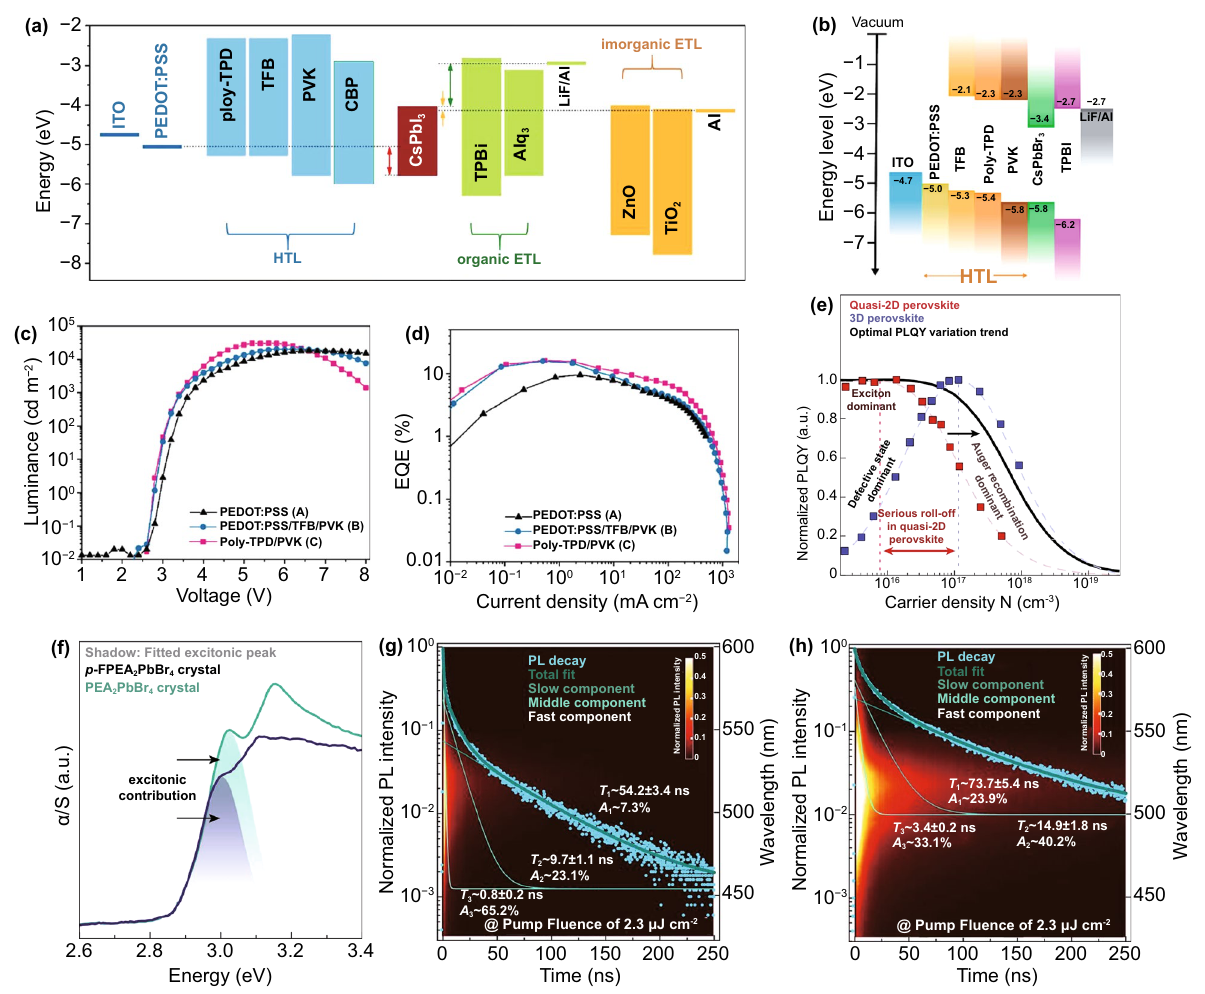
Fig. 7 a Schematic diagram showing energy levels of typical electrodes, charge transport materials and CsPbI 3 . Copyright 2020 American Chemical Society [100]. b Energy level diagrams of quasi-2D PeLEDs and different HTLs. c L-V and d EQE-J of PEDOT: PSS, PEDOT: PSS/ TFB/PVK, poly-TPD/PVK. Copyright 2020 American Chemical Society [102]. e Experimental PLQYs of quasi-2D perovskite and 3D perovs- kite films as a function of carrier density. f Absorption spectra of PEA2PbBr4 and p-FPEA 2 PbBr 4 single crystals. Time- and wavelength-depend- ent photoluminescence mapping under a pump fluence of 2.3 μJ cm −2 for g PEA and h p-FPEA films. Copyright 2021 Springer Nature